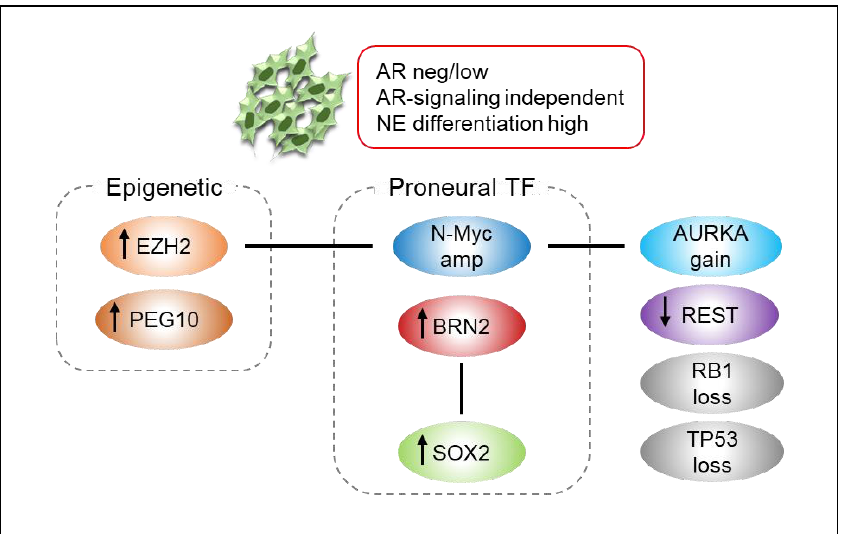
Figure 2. Neuroendocrine prostate cancer (NEPC) is characterized by loss of tumor suppressors, activation of oncogenic drivers, and epigenetic changes. AR androgen receptor, NE neuroendocrine, TF transcription factor. Up and down arrows indicate upregulation and downregulation, respectively.